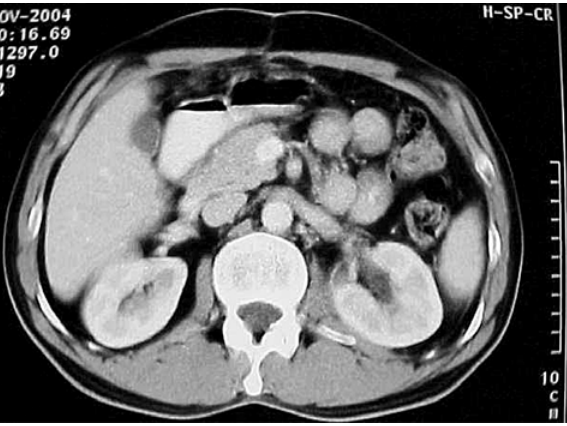
Figure 6 – Follow up computed tomography image of case 1 at two years without any local